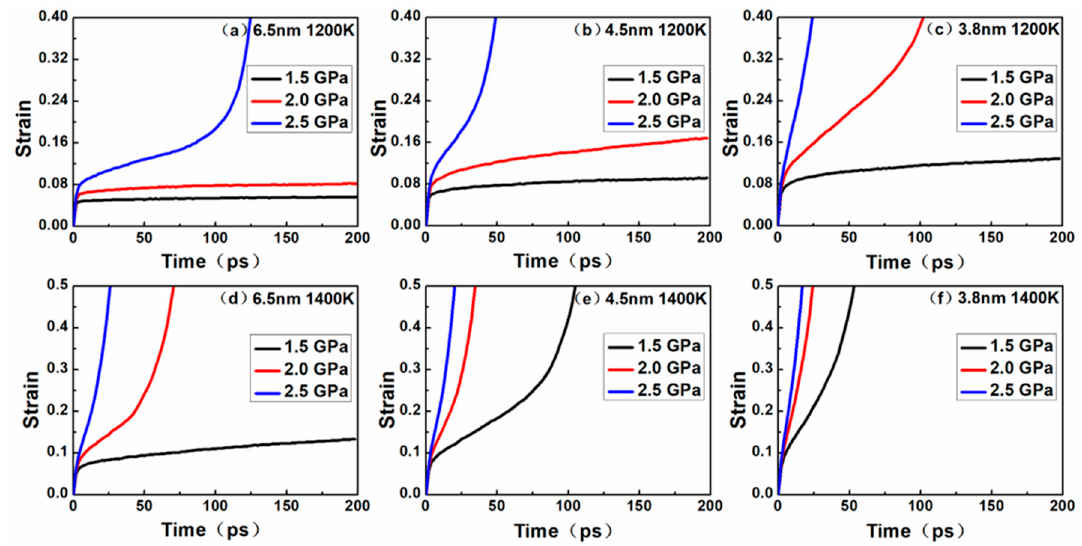
Figure 2. Time versus creep strain curves for the nanocrystalline models with grain sizes of ( a ) 6.5 nm at 1200 K; ( b ) 4.5 nm at 1200 K; ( c ) 3.8 nm at 1200 K; ( d ) 6.5 nm at 1400 K; ( e ) 4.5 nm at 1400 K; ( f ) 3.8 nm at 1400 K under the stress levels of 1.5, 2.0 and 2.5 GPa.